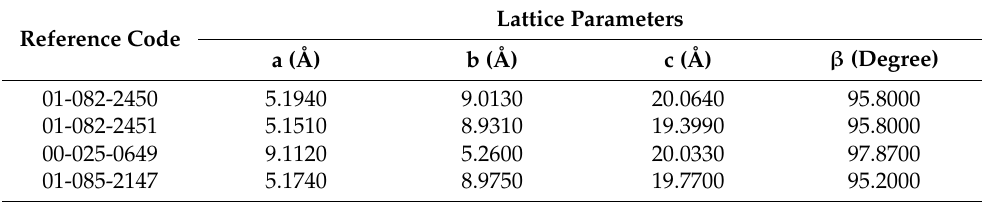
Table 3. Crystallographic parameters of some muscovite samples available in the X-ray diffraction (XRD)